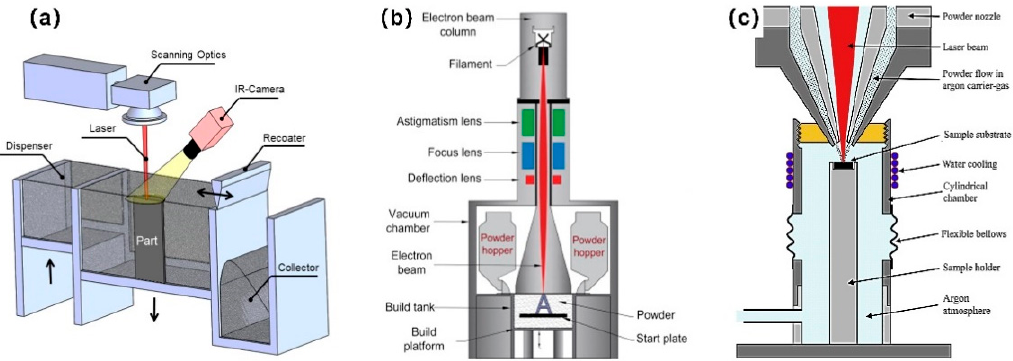
Figure 1. Schematic illustrations of the widely applied metal additive manufacturing (AM) processes: ( a ) Selective laser melting (SLM). Reprinted with permission from ref. [33]; ( b ) electron beam melting (EBM). Reprinted with permission from ref. [34]. Copyright 2017 Elsevier; ( c ) laser metal deposition (LMD). Reprinted with permission from ref. [35]. Copyright 2019 Elsevier.